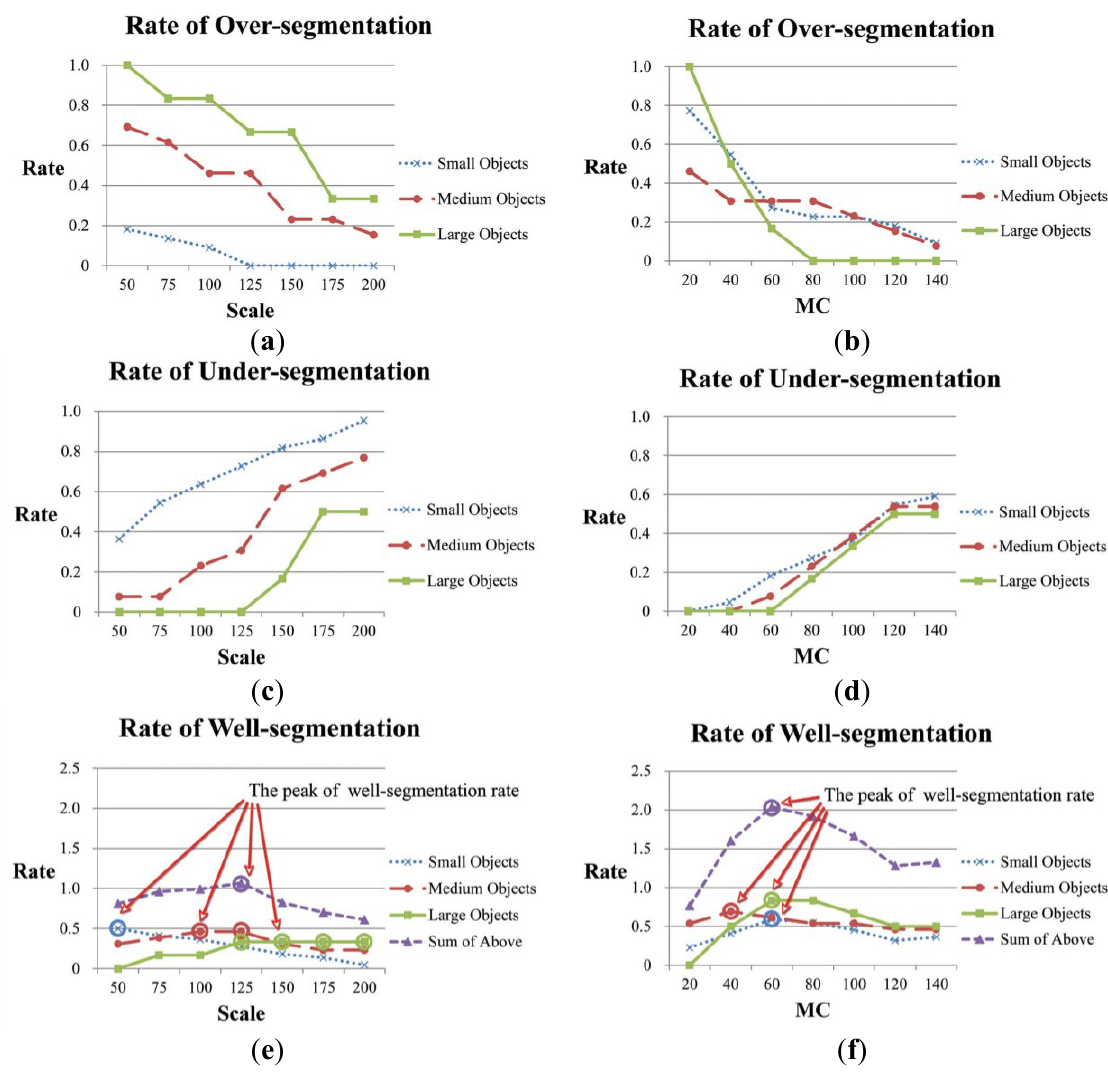
Figure 13. Quantitative assessment results by different MC values in R2. Plots on the left side of the figure display the over-, under- and well-segmentation rate of eCognition segmentation using different scale parameters. The corresponding plots of the proposed method are displayed on the right part. ( a ) Rate of over-segmented objects by eCognition segmentation; ( b ) Rate of over-segmented objects by the proposed method; ( c ) Rate of under-segmented objects by eCognition segmentation; ( d ) Rate of under-segmented objects by the proposed method; ( e ) Rate of well-segmented objects by eCognition segmentation; ( f ) Rate of well-segmented objects by the proposed